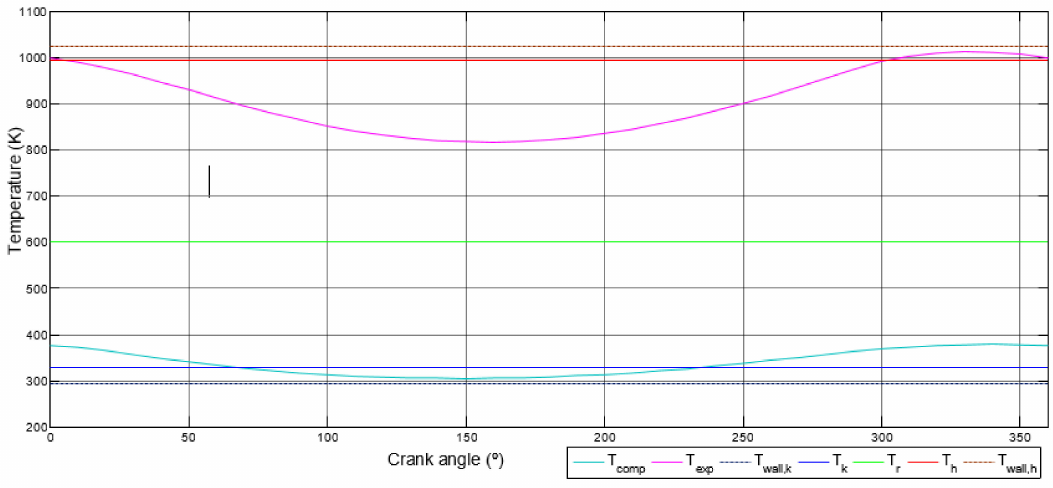
Figure 17. Temperature distribution in the simple model.